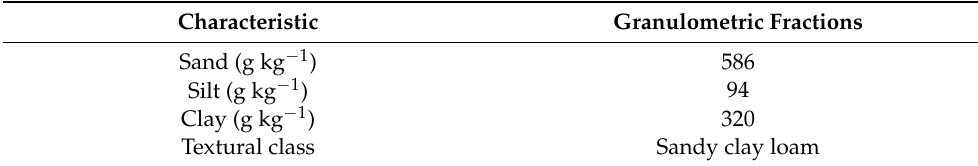
Table 1. Soil texture of topsoil in the experimental